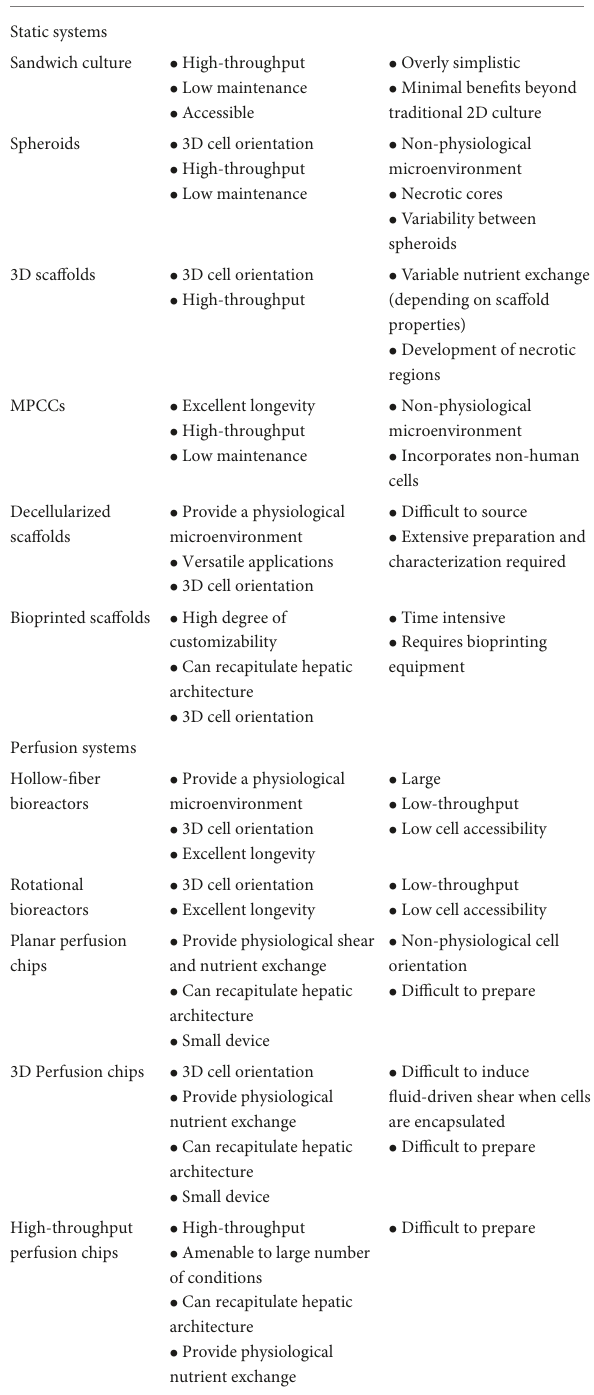
TABLE 1 Comparative overview of different physiomimetic culture